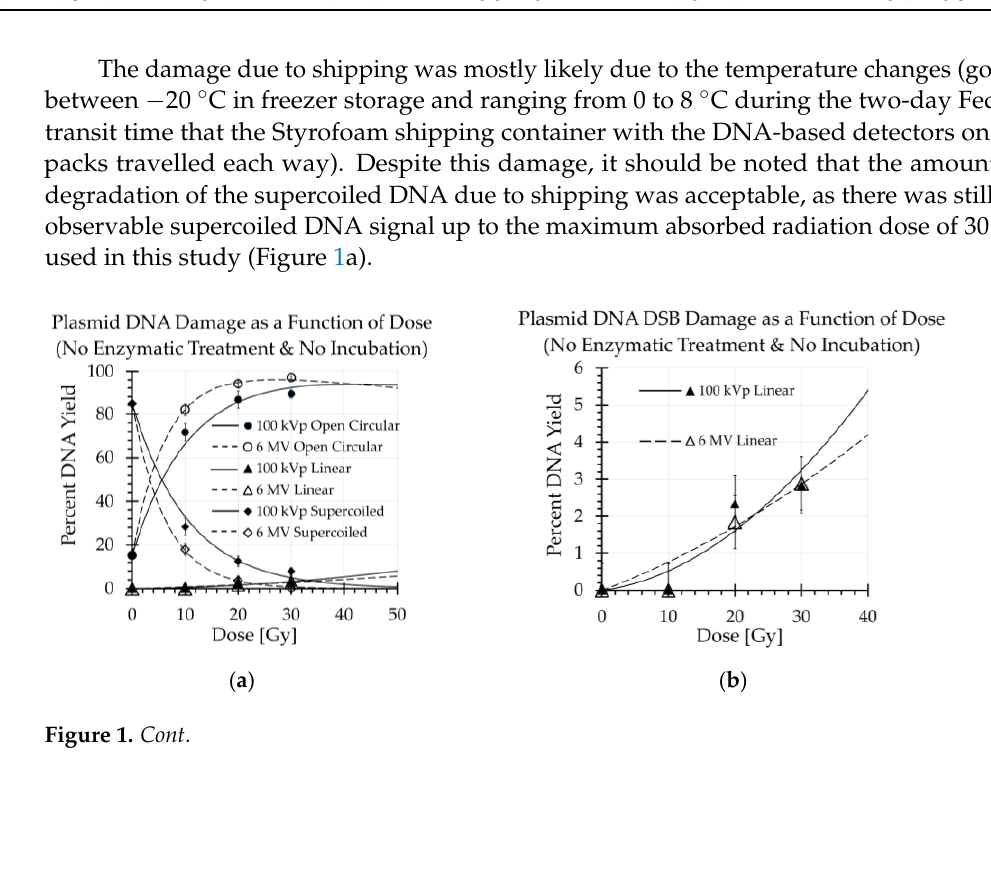
( c ) ( d ) Figure 1. The measured yields at 0, 10, 20, and 30 Gy are plotted and the McMahon and Currell robust plasmid DNA curve fits of the data are displayed for ( a ) control and irradiated samples, ( b ) a magnified view of the linear DNA conformation as a function of dose shown in ( a ), ( c ) samples incubated post irradiation, and ( d ) samples incubated with enzymatic (Nth and Fpg) treatment post irradiation [25]. 2.2. Yields of SSBs and DSBs/Gy/Plasmid of Irradiation We measured the amount of open circular conformation induced by the 6 MV beam to be 1.18, 1.10, and 1.11 times greater than the 100 kVp beam at doses of 10, 20, and 30 Gy, respectively (Figure 1a). Hence, there was a 10% to 18% greater induction of SSBs in the 6 MV versus the 100 kVp beam. After incubation alone, the measured percent yields of DSBs from 10 to 30 Gy, representing clustered heat labile sites (CHLS), were 20% to 30% greater for the 6 MV than the 100 kVp beam (Figure 1c). After enzymatic treatment, the measured percent yields of DSBs, representing clustered oxidized base damage (COBD), were 8% to 80% greater for the 6 MV than the 100 kVp beam (Figure 1d). Hence, these results show that significantly more CHLS and COBD damage occurred in the lower